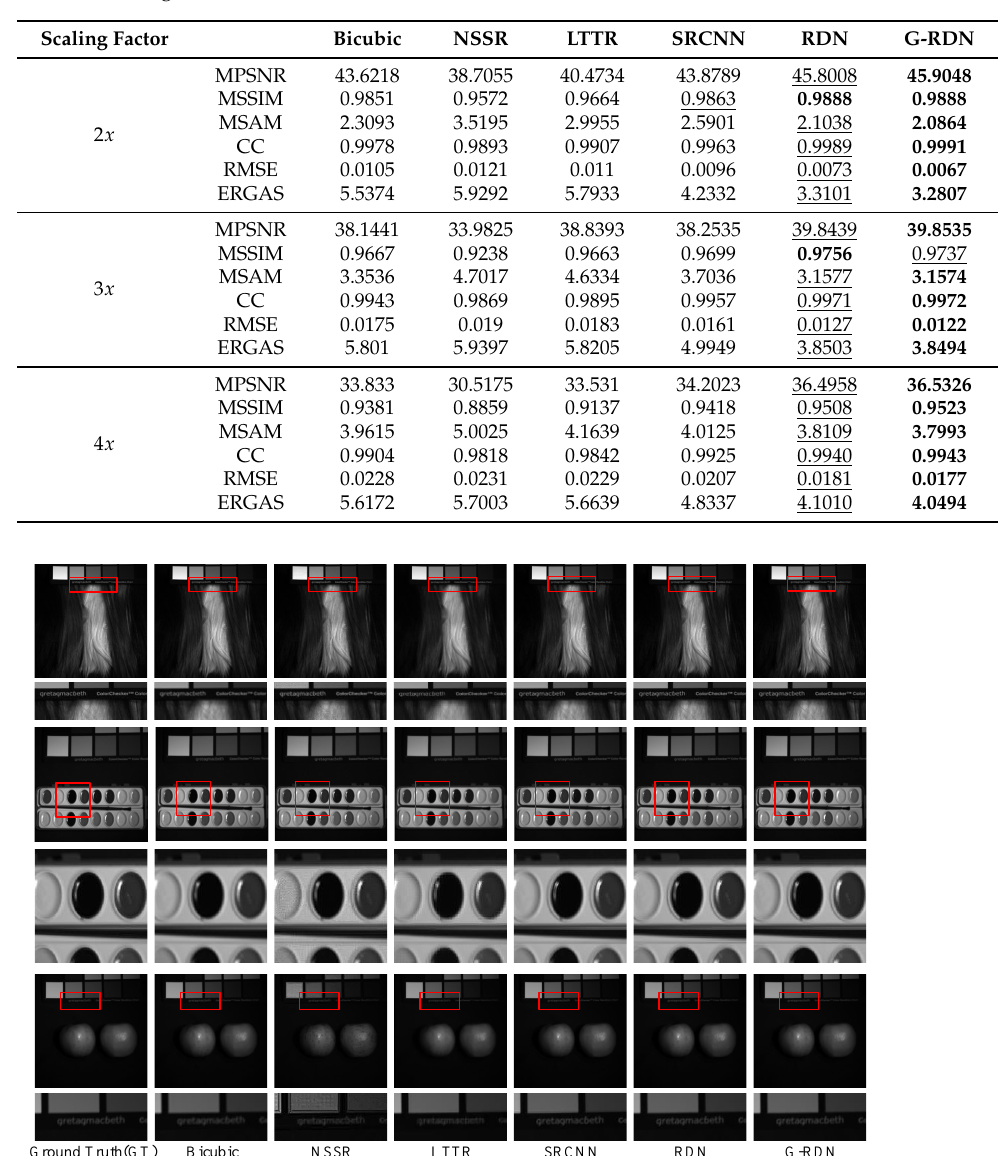
Table 1. Average measurement metrics for the three test HSIs for the CAVE dataset.